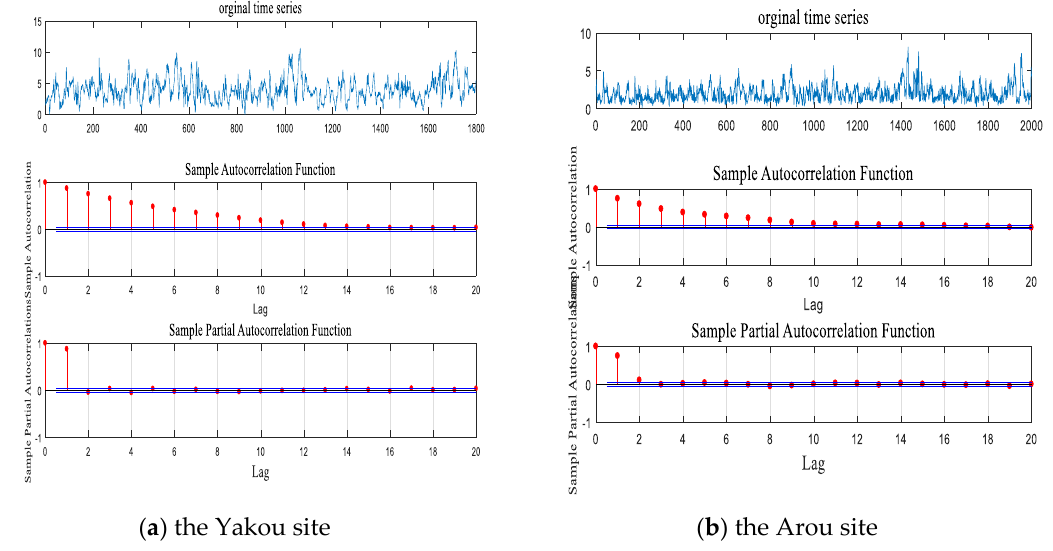
Figure 7. Origin series of wind speed and the ACF and PACF of the series. Table 4. ARIMA model of three sets of time-series data.